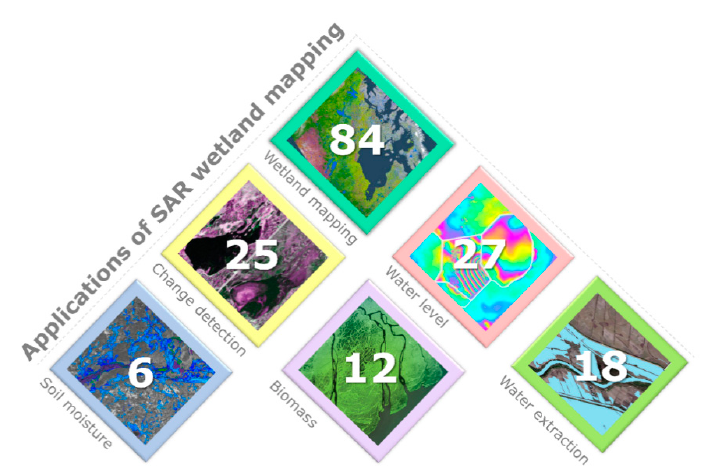
Figure 12. Number of studies for wetland mapping, change detection, water level monitoring, inundation mapping (water extraction), biomass and soil moisture application are shown.